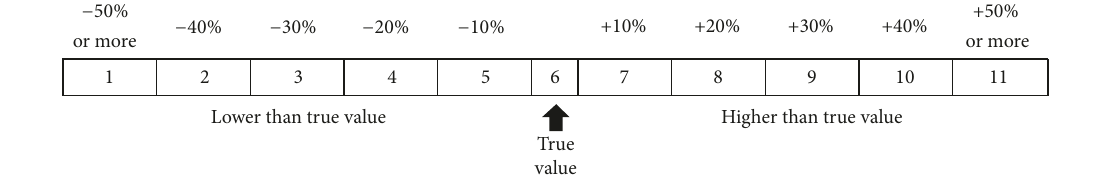
Figure 1: Response scale used for the bias subsection.